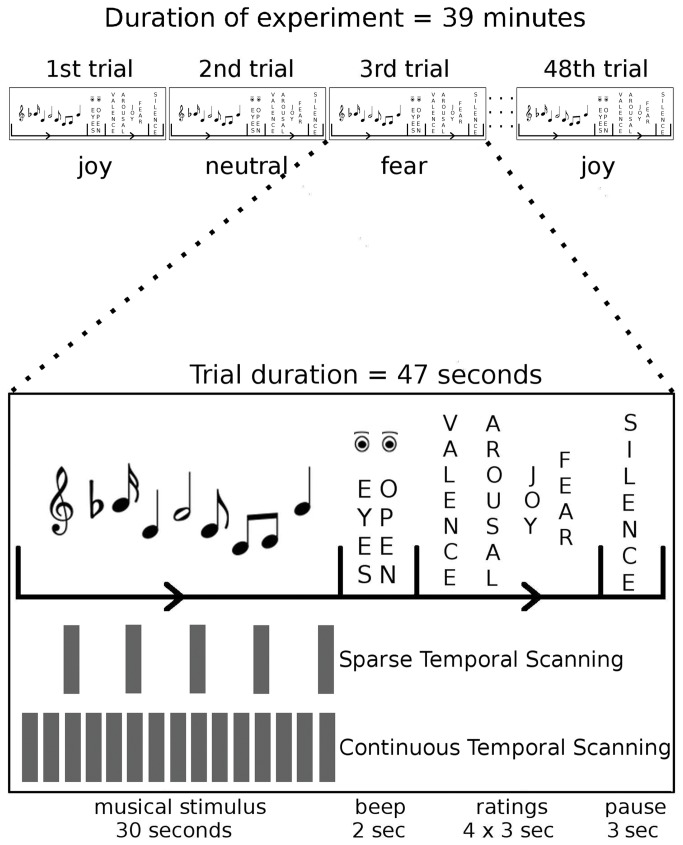
Experimental design.In each trial, a music stimulus (either joy, fear, or neutral) was presented in pseudorandom order for 30 s. Participants listened to the music with their eyes closed. Then, a beep tone signaled to open the eyes and to commence the rating procedure. Four ratings (felt valence, arousal, joy, and fear) were obtained in 12 s, followed by a few seconds of pause. Trial duration was approximately 47 s, the experiment comprised of 48 trials. Grey bars indicate volume acquisitions for sparse and continuous scanning groups (TR = 2 s).